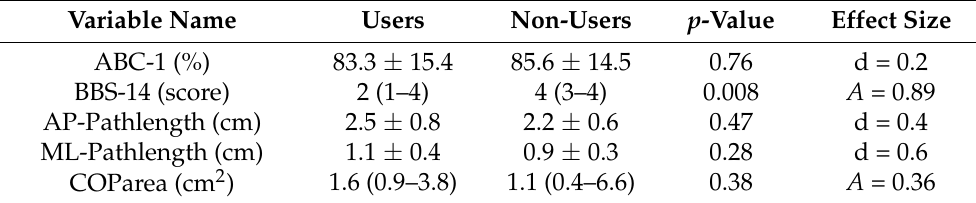
Figure 1. ( A ) Activities-Specific Balance Confidence (ABC) scale score for Item 1 (walking around the house). A higher score indicates higher balance confidence. The difference between the cannabis Users and the Non-Users was not significant ( p = 0.76, Cohen’s d = 0.1). The data are mean ± SEM. ( B ) Berg Balance Scale (BBS) score for Item 14 (stand on one leg). A higher score indicates better balance performance. The difference between the cannabis Users and the Non-Users was significant (Mann–Whitney U test: p = 0.008, Common language effect size A = 0.89). The bar represents the median score, and A represents the probability that a random datum from the Non-Users will be larger than a random datum from the Users (i.e., 89% probability). Table 2. Central tendency, variability, significance, and effect size (d or A ) for the study